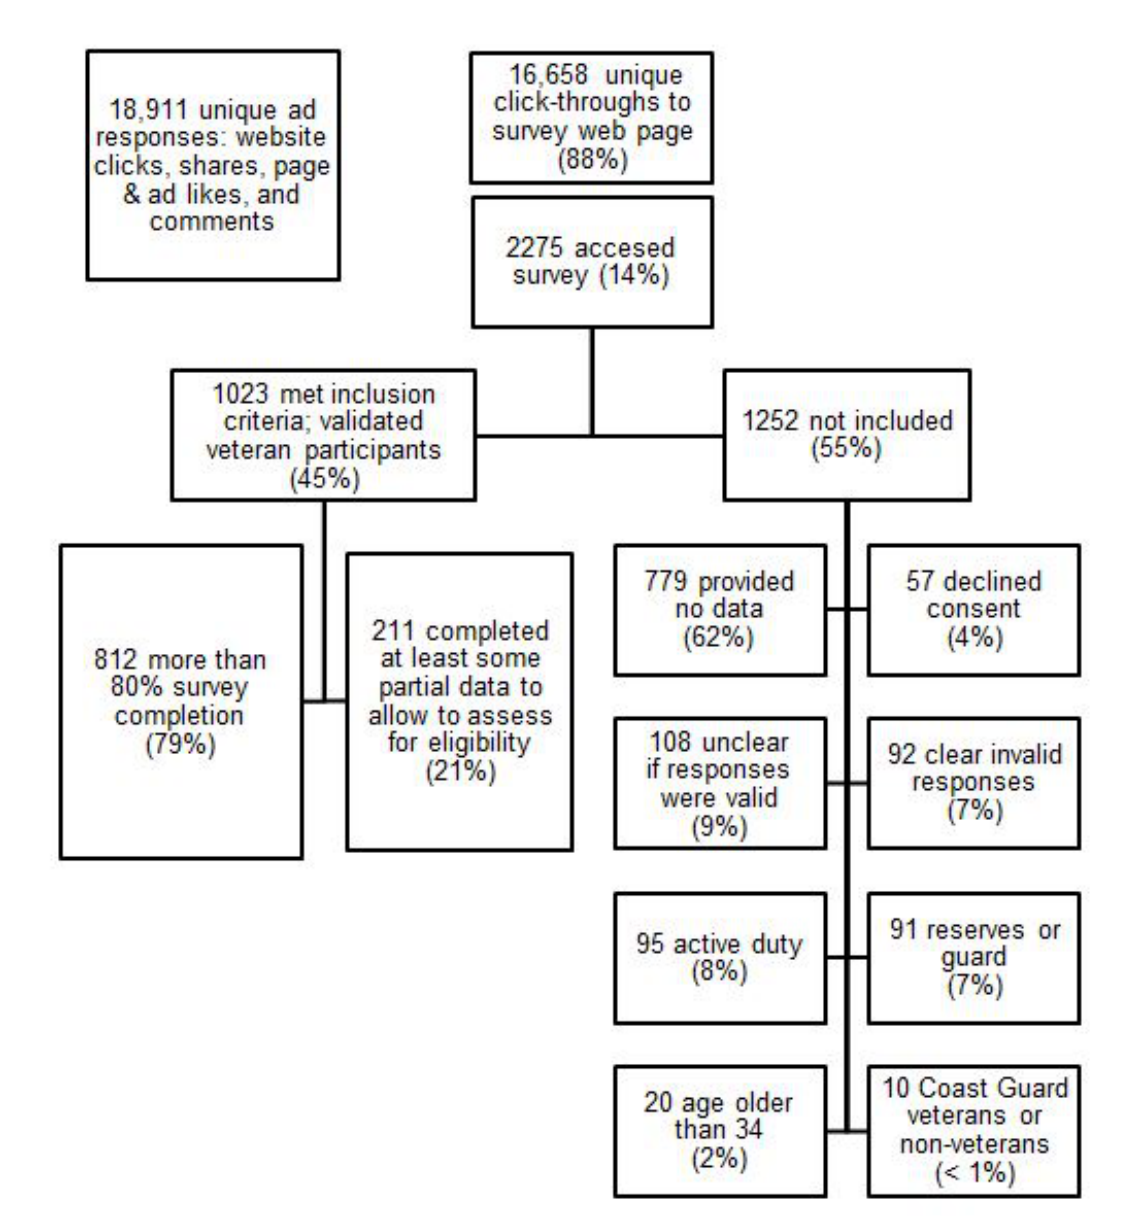
Figure 2. Flow diagram of sample